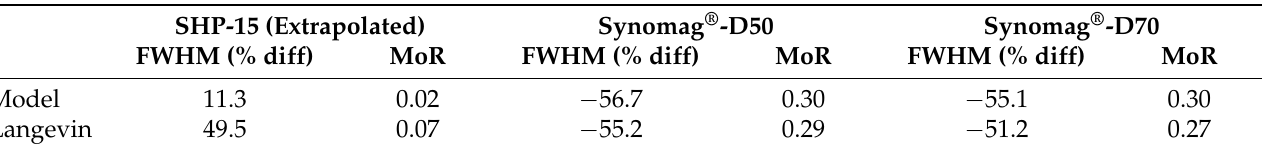
Table 2. Quantification of the goodness of fit of Figure 3, based on difference in full-width at half-maximum from the experimental data and the mean of absolute residuals in the FWHM window (the closer it is to 0, the better it